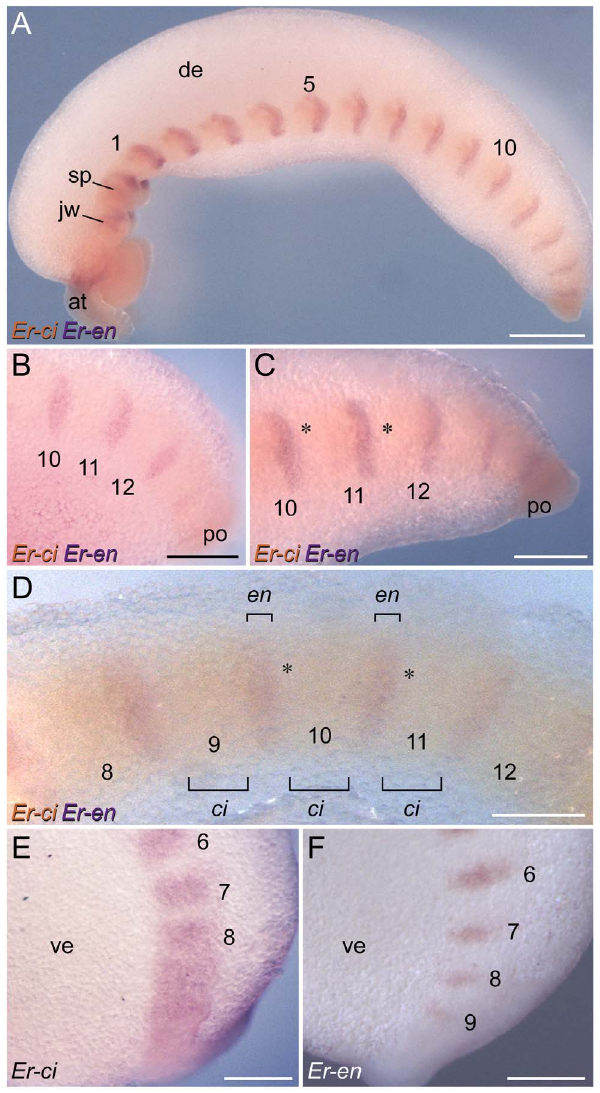
Figure 8. Localisation of engrailed and cubitus interruptus expression in embryos of E. rowelli . Labelling for engrailed is illustrated in purple and for cubitus interruptus in orange in A–D. Embryos in lateral view. Anterior is left and dorsal is up in all images. Leg-bearing segments are numbered. (A) Overview of a stage IV embryo. (B) Posterior end of a stage III embryo. Note that no gaps are evident between the engrailed and cubitus interruptus domains. Note also that there might be a co-expression of the two genes at least in cells located within the posterior-most engrailed stripes, as there is a continuous belt of cubitus interruptus expression in this body region at that stage (cf. E and F; see alsoFigures 6F,7B). (C) Posterior end of a stage IV embryo. Asterisks indicate gaps between subsequent engrailed and cubitus interruptus domains. (D) Through-light micrograph showing subsequent domains of engrailed and cubitus interruptus in a stage IV embryo. Note gaps between the engrailed and cubitus interruptus domains (asterisks). (E) Expression of cubitus interruptus at the posterior end of a stage II embryo. (F) Expression of engrailed at the posterior end of a stage II embryo. Abbreviations: at , antenna; ci , cubitus interruptus domains; de , dorsal extra-embryonic tissue; en , engrailed domains; jw , jaw; po , proctodaeum; sp , slime papilla; ve , ventral extra-embryonic tissue. Scale bars: 500 m m (A), 250 m m (B, C, E, F), 200 m m (D).